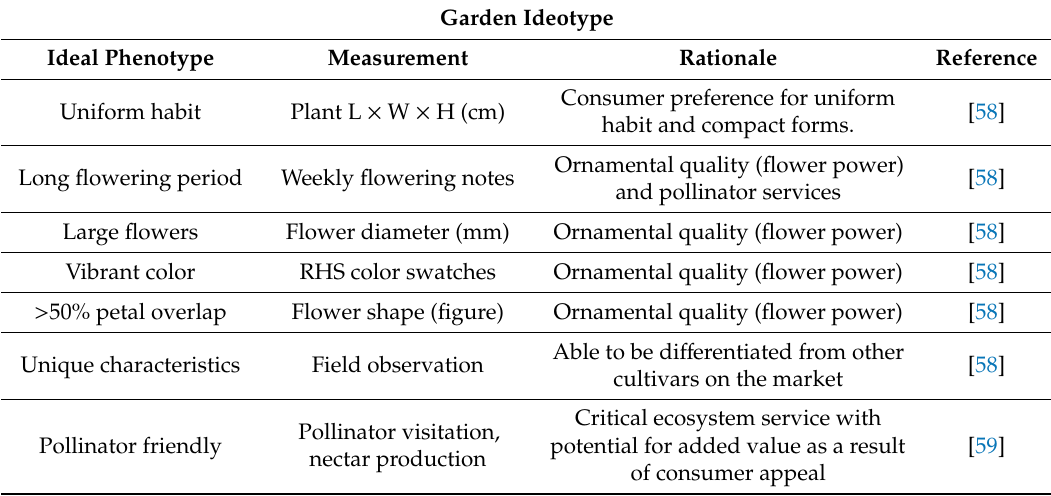
Table 3. The proposed perennial flax garden ideotype with the ideal phenotypes for various traits, the measurements required to quantify them, and the rationale for the choice of each